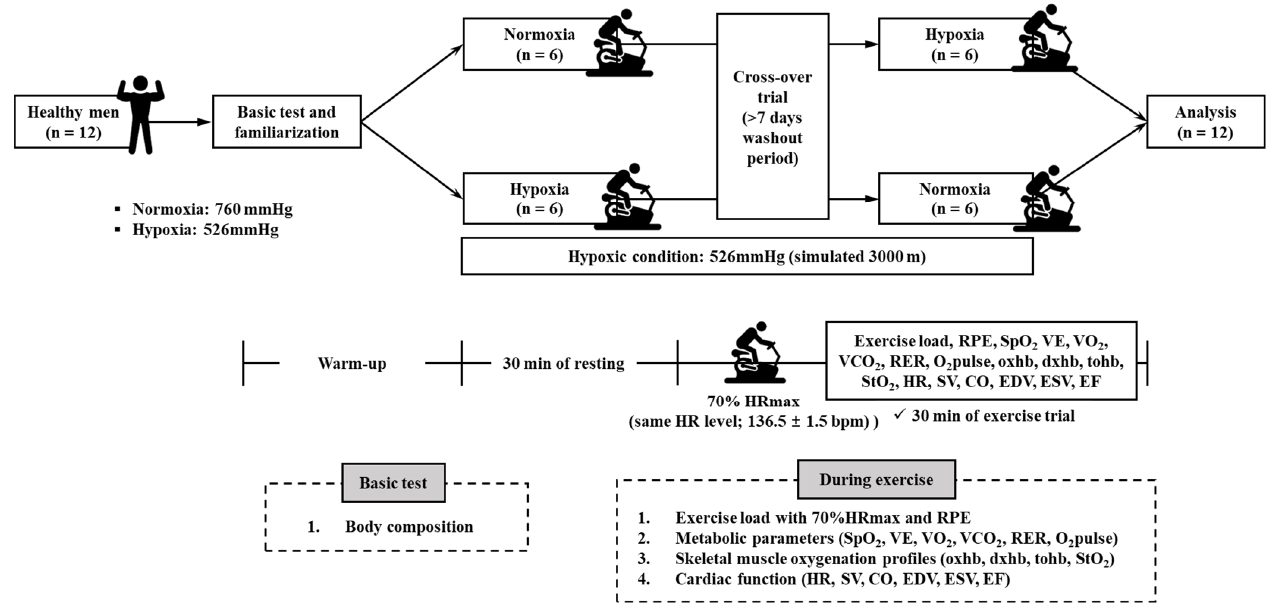
Figure 2. Study design. HRmax: maximal heart rate; RPE: rating of perceived exertion; SpO 2 : saturation of percutaneous oxygen; VE: minute ventilation; VO 2 : oxygen uptake; VCO 2 : carbon dioxide excretion; RER: respiratory exchange ratio, O 2 pulse: oxygen pulse; oxhb: oxygenated hemoglobin; dxhb: deoxygenated hemoglobin; tohb: total hemoglobin; StO 2 : tissue oxygenated saturation; HR: heart rate; SV: stroke volume; CO: cardiac output; EDV: end-diastolic volume; ESV: end-systolic volume, EF: ejection fraction.